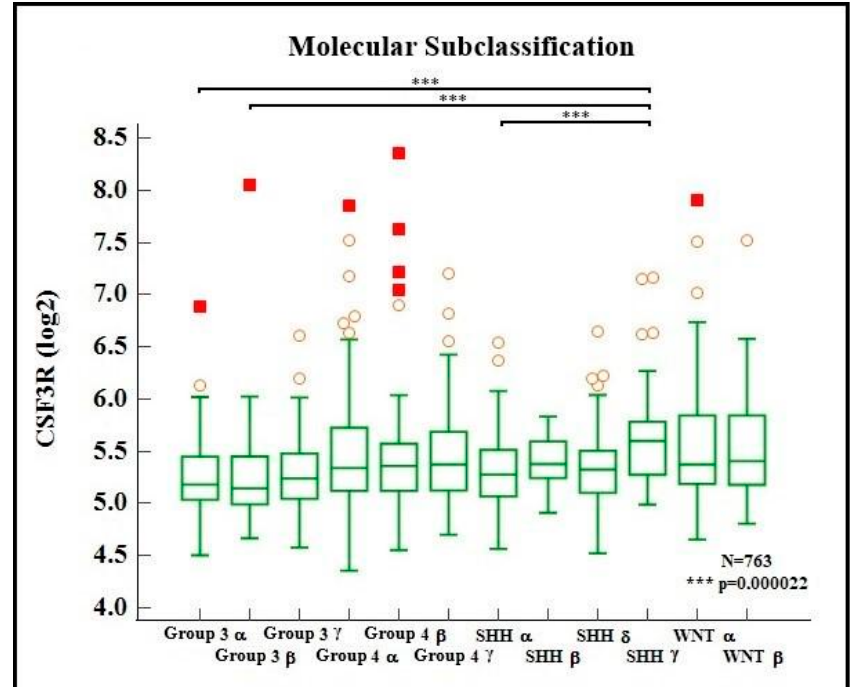
Figure 3. CSF3R expression in the molecular subgroups of medulloblastomas. Red circles and squares represent, respectively, outside and far out values (larger than the upper quartile plus 1.5 and 3 times the interquartile range, respectively). Source: the authors. Compiled using MedCalc ® version 20.115 (MedCalc Software Ltd., Ostend, Belgium).